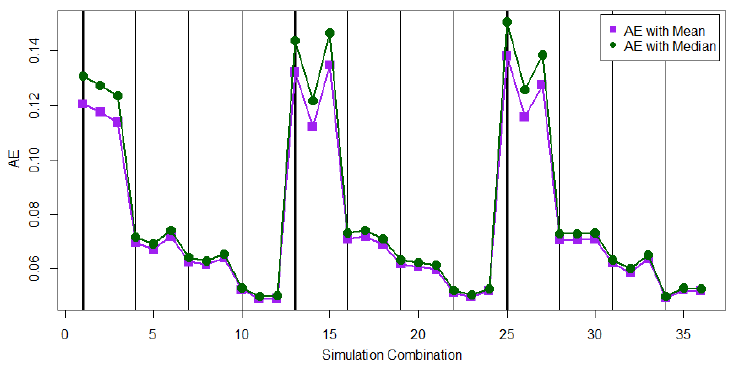
Figure 6. The EAEs of ˆ δ SE and ˆ δ AE for the case of β 1 = β 2 . Table 3. The EAEs for ˆ δ SE and ˆ δ AE under two different Burr type XII